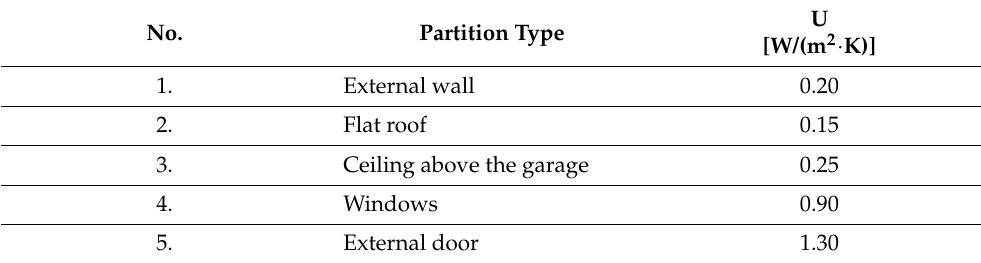
Table 3. Heat transfer coefficients U in accordance with the Technical Conditions